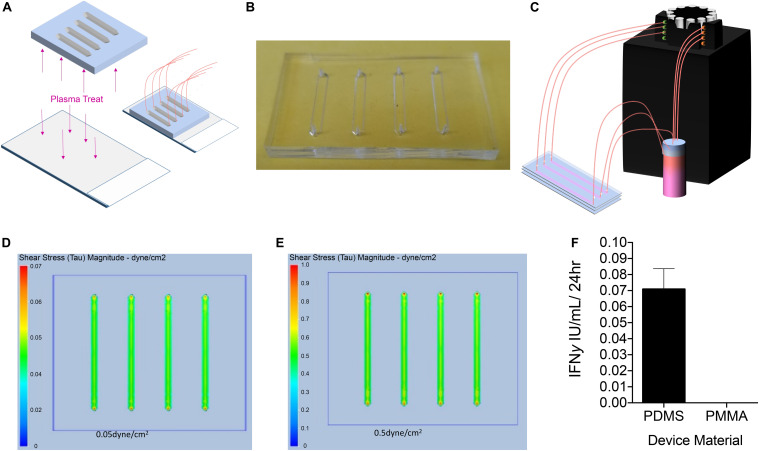
Design, Manufacturing, and Analysis of Microfluidic PDMS Devices. (A) To determine the effect of fluidic laminar shear stress on PLC transduced with a lentiviral vector encoding a myeloid codon-optimized bioengineered FVIII containing high expression elements from porcine FVIII (PLC-mcoET3), we designed and manufactured PDMS devices with the soft lithography method and adhered them to plasma-treated glass to form a closed channel. (B) Representative image of single-use PDMS device. (C) Upon completion, devices were connected to a reservoir of media and to a peristaltic pump to flow media through the devices to generate shear stresses of 0.05 or 0.5 dyne/cm2. (D,E) Computational fluid dynamics analysis showing shear stress maps at the base of the channels, demonstrating that PLC were experiencing either (D) 0.05 dyne/cm2 or (E) 0.5 dyne/cm2 throughout the channel, with a slight increase in the very center of the channel. (F) IFNγ secretion by PLC on microfluidic devices. PLC cultured on plasma-treated glass slides produced IFNγ while cells cultured on a PMMA device did not (n = 3).